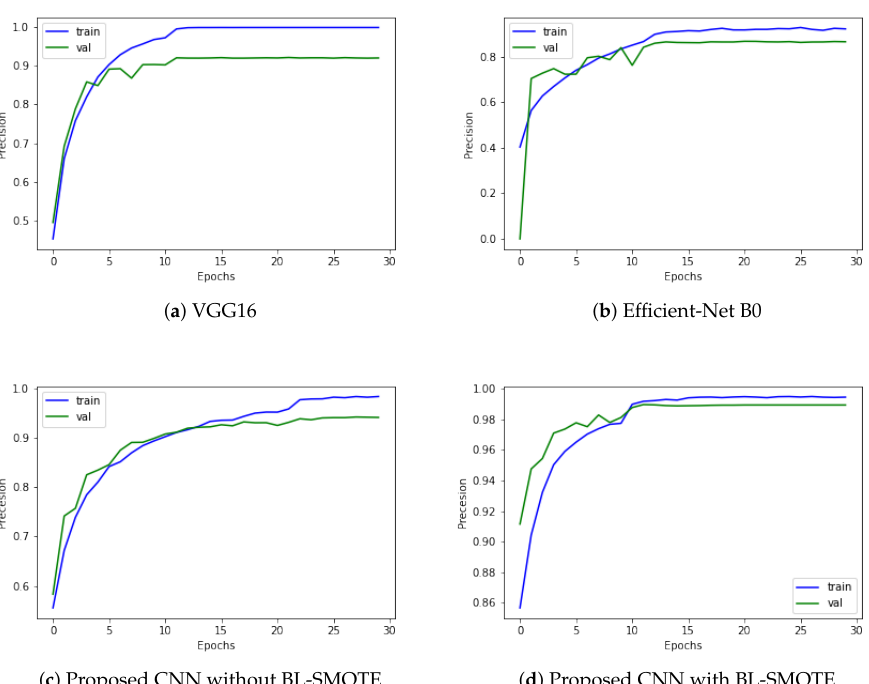
Figure 9. Precision results to provide an overview of the trade-offs between actual positive and pos- itive predictive value for ( a ) VGG16, ( b ) Efficient-Net B0, and ( c , d ) DAD-Net with and without up-sampling.